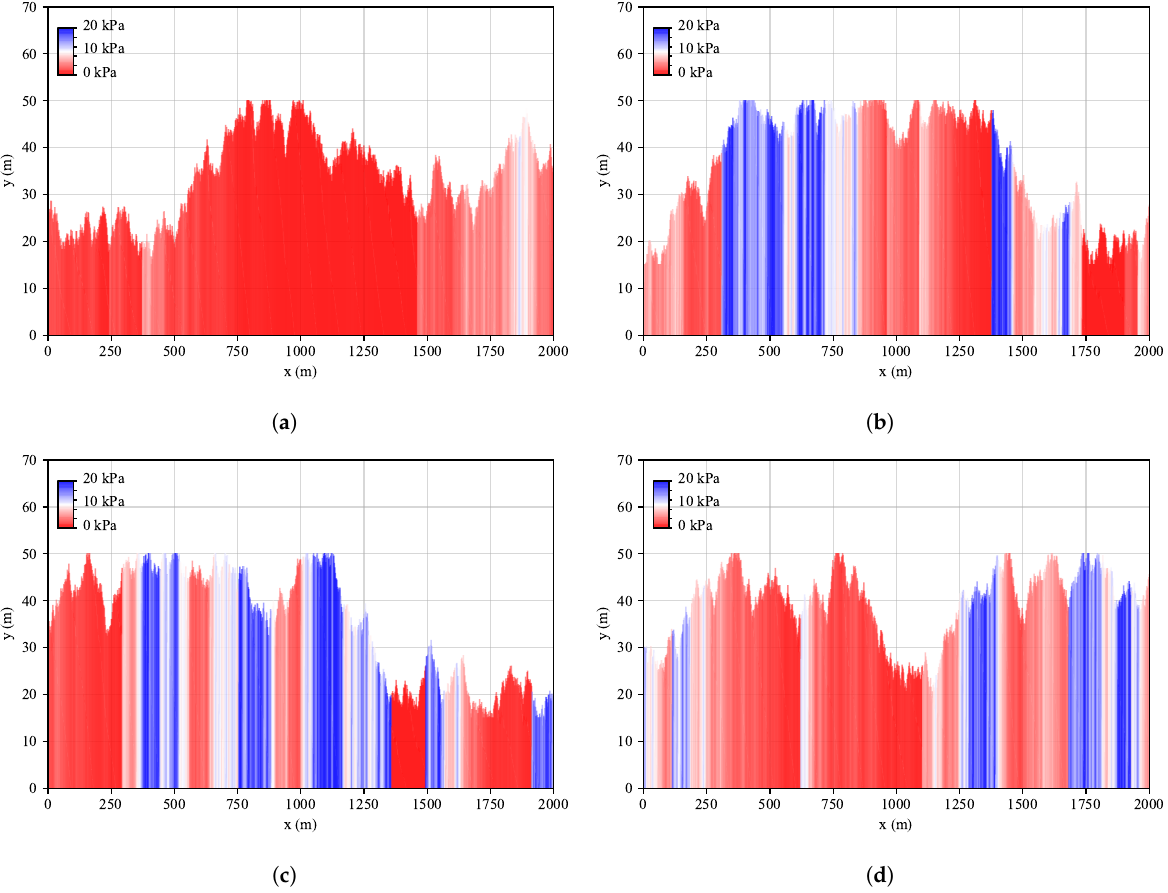
Figure 7. Cohesion values of the analytical environment with random geologies. ( a ) Episode 2. ( b ) Episode 3. ( c ) Episode 4. ( d ) Episode